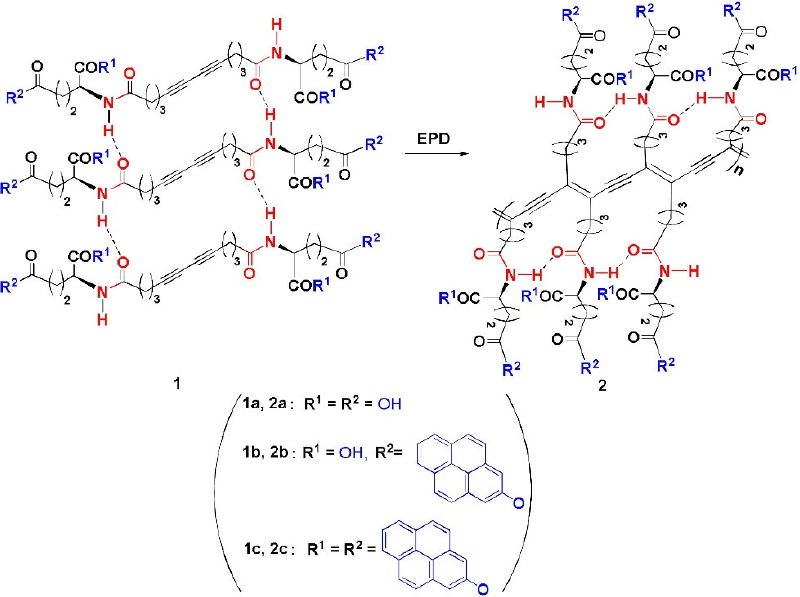
Figure 2. The EPD (electrophoteric deposition) process of polymeric products 2a–2c. Reproduced with the permission of Reference [16]. Copyright 2017, Elsevier.